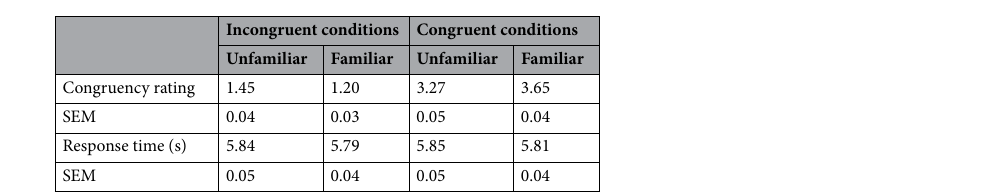
Table 1. Behavioral results. Response time is the time relative to the onset of each trial. SEM standard error of the